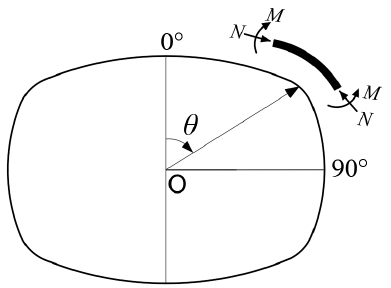
7 of 11 Figure 3. Cross-section of quasi-rectangular tunnel: s 1 = 0.76 m; d 1 = 4.44 m; d 2 = 3.68 m; h 1 = 2.75 m; h 2 = 1.99 m. Table 1 gives the comparison of the results in terms of the maximum bending mo- ment M (kN.m) and the maximum normal force N (kN) of the tunnel lining considering different tunnel depths H . It could be found from Table 1 that the outcomes calculated by the present HRM are very close to the ones of Zhang et al. [4]. The relative error is less than 1.5%. This agreement means that the HRM method is valid to evaluate the internal forces of the quasi-rectangular tunnel lining. Table 1. Comparison of the HRM and results of Zhang et al. [4] with different tunnel depths H.